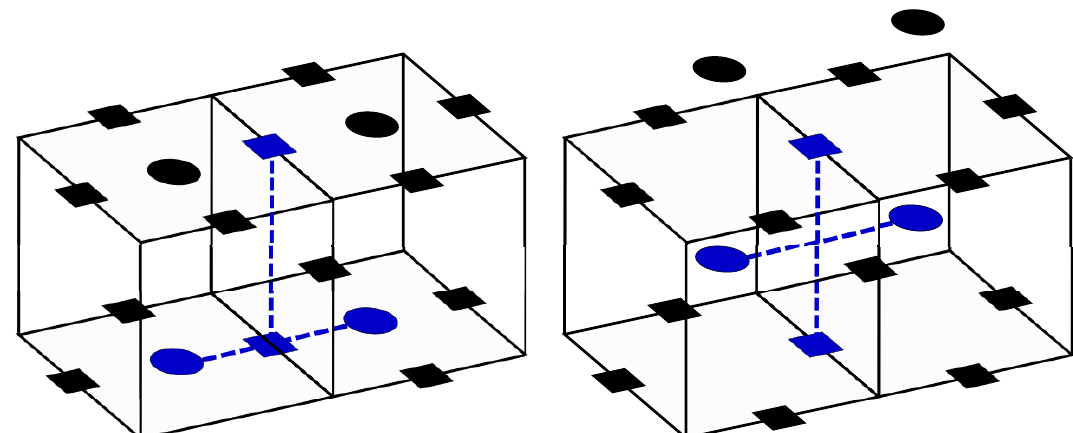
creates a temporal star. Left: Configurations of σ x (squares) Figure 2: Renaming s x p and s x (circles) classical spins at two time slices l (cid:34) and ( l + 1 ) (cid:34) (the horizontal layers of the 3 D lattice). Identifying the two plaquettes in the lower layer as p and q , the ( l (cid:34) ) s x ( l (cid:34) ) σ x (( l + 1 ) (cid:34) ) σ x ( l (cid:34) ) blue spins connected by dashed lines illustrate the s x p q pq pq bond from the k (cid:48) term of β (cid:48) H . Right: We rename the s x spins to σ x , shifting 3 D p p , p + 1 2 them in the lattice so that they sit between each plaquette p at l (cid:34) and p at ( l + 1 ) (cid:34) . ( l (cid:34) ) σ x ( l (cid:34) ) σ x (( l + 1 ) (cid:34) ) σ x ( l (cid:34) ) and The k (cid:48) term illustrated in blue becomes σ x pq pq p , p + 1 q , q + 1 2 can be clearly recognized as a temporal “star” term. Notice that all such temporal stars are centered around the plane between two cubes of the lattice, rather than about a vertex like spatial